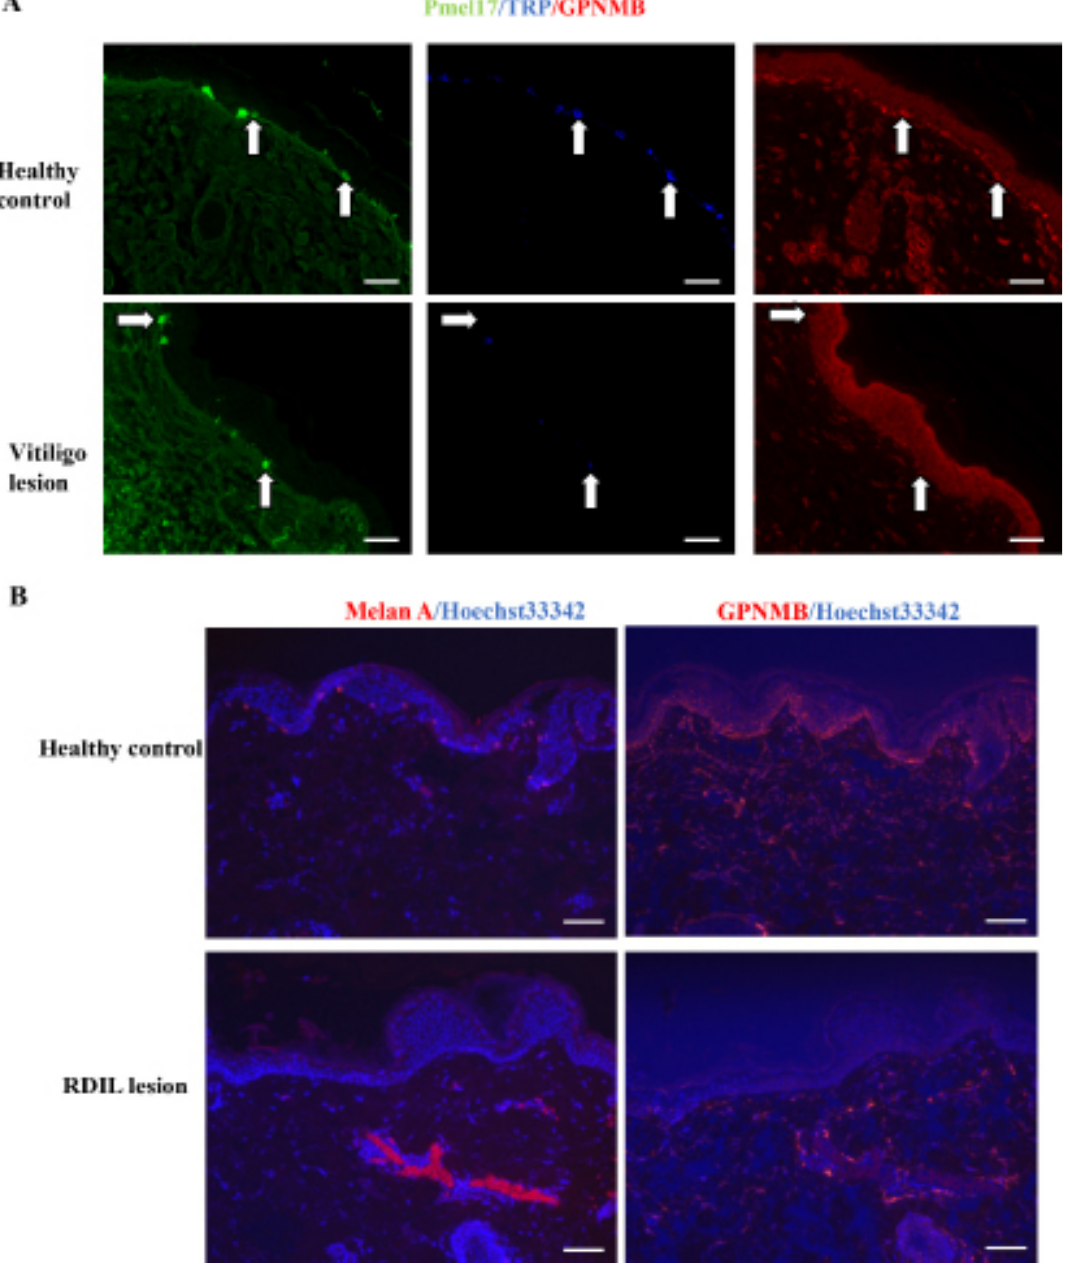
Figure 5. Downregulated GPNMB expression in vitiligo and RDIL. Skin sections from lesion site of vitiligo and healthy control were stained with anti-Pmel17 in green, anti-transient receptor potential (TRP) in blue and anti-GPNMB in red (A). Skin sections from lesion site of RDIL were stained with anti-GPNMB in red (B). White arrows in (A) indicate melanocytes. Scale bar: 100 μm